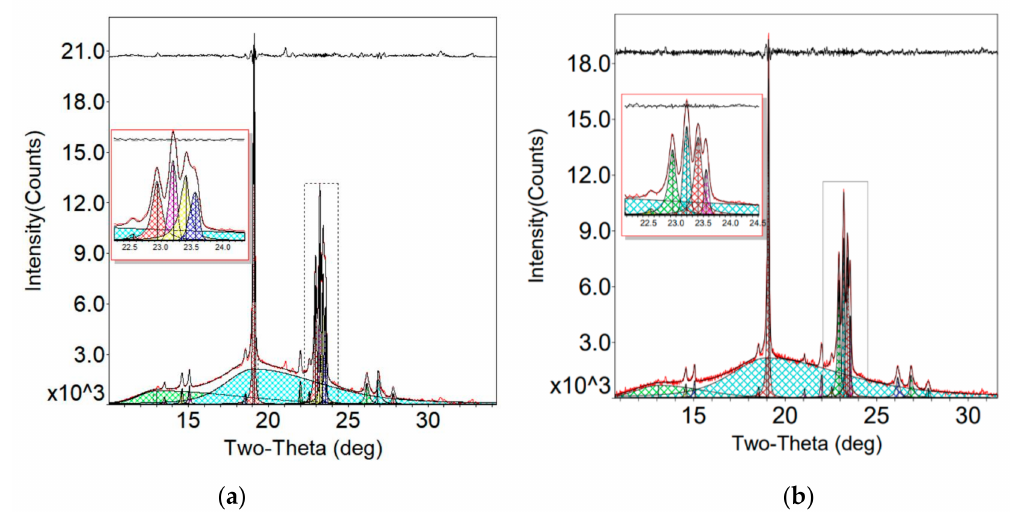
Figure 15. XRD analysis of the electrolytes from: ( a ) Group A, and ( b ) Group